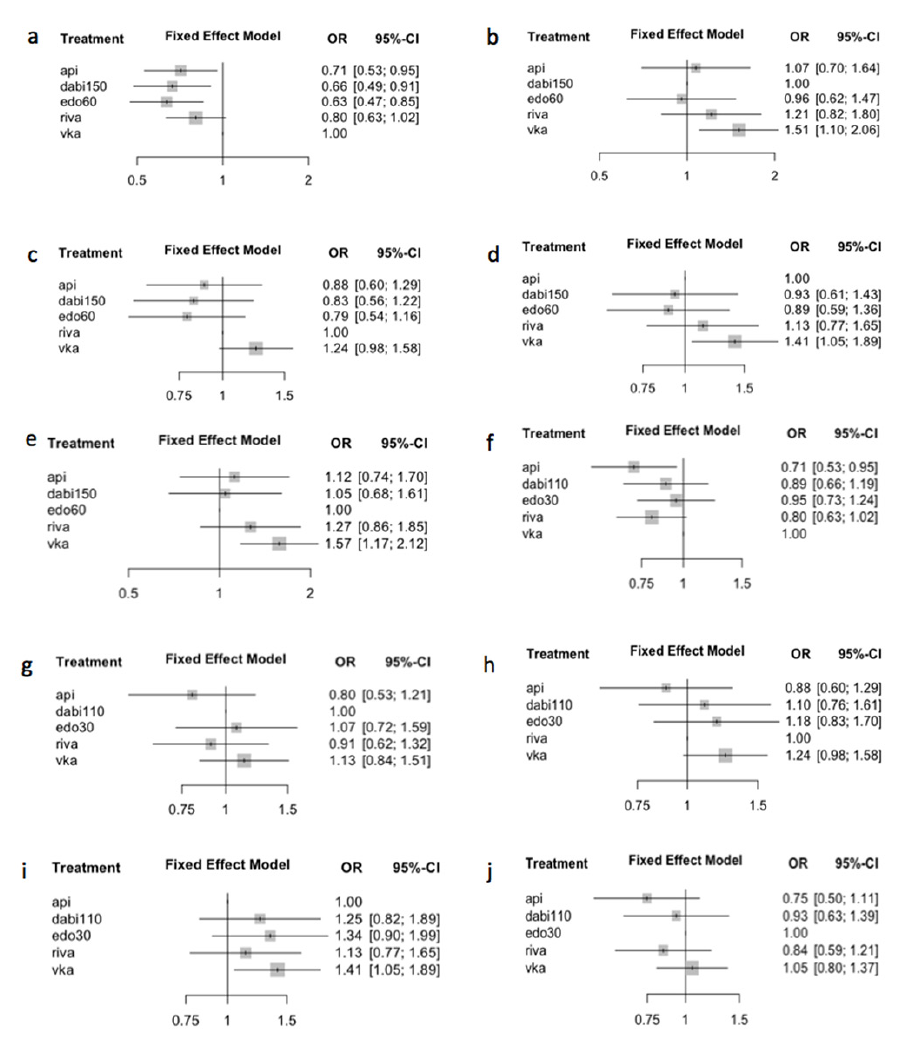
Forest plots of indirect comparisons between direct oral anticoagulants in stroke and systemic embolism prevention including high-dose dabigatran and edoxaban (a–e) and low-dose dabigatran and edoxaban (f–j). api = apixaban; CI = confidence interval; dabi110 = dabigatran 110 mg; dabi150 = dabigatran 150 mg; edo30 = edoxaban 30 mg; edo60